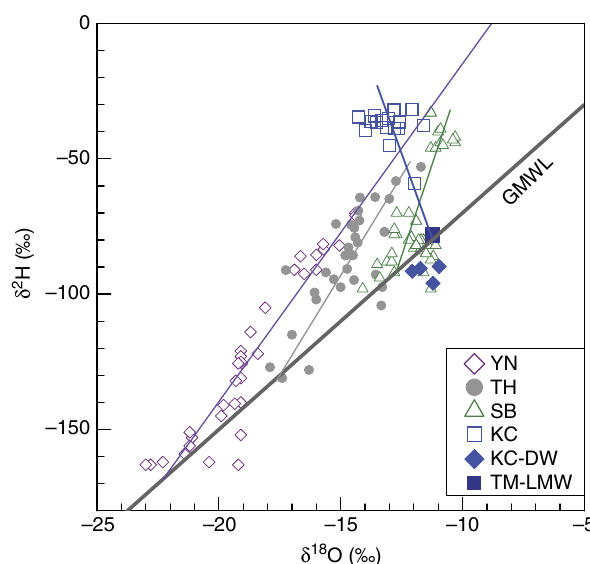
Figure 1 | d 18 O and d 2 H of subsurface fracture waters. KC represents Kidd Creek (data from this study). Some other sites (YN, Yellowknife; TH, Thompson; SB, Sudbury) in the Canadian Shield (data source: ref. 8), local meteoric water in Timmins, Ontario (TM-LMW), Global Meteoric Water Line (GMWL) and drilling water in the Kidd Creek mine (KC-DW) are also plotted for comparison. Error bars (1 s ) are smaller than the symbols. Similar to what is observed in the subsurface fracture waters in South Africa 38,69 , less saline samples (typically from shallower depths) have oxygen and hydrogen isotope compositions that lie on the GMWL due to mixing with surface water-derived components. While some recharge of surface water to depth cannot be ruled out 38 , the practice of recirculation of surface lake water to depth for use as drilling and service water in the mine is the most likely explanation for the presence of meteoric waters at such depths. KC-DW lies slightly below the GMWL, attributable to water evaporation in the local source lake. Brine fracture waters lie well above the GMWL due to intensive fluid–rock interaction as seen at other sites across the Canada Shield 8 . For each site, a mixing line can be drawn between the most saline fracture water end-member and meteoric water end-members that lie on the GMWL. The samples from this study record some of the most elevated d 2 H and d 18 O values ever observed ( (cid:3) 31.6 % to (cid:3) 39.5 % , and (cid:3) 11.6 % to (cid:3) 14.3 % , respectively) and attest to the lack of significant mixing with surface/drilling waters in the fracture fluids that are the focus of this